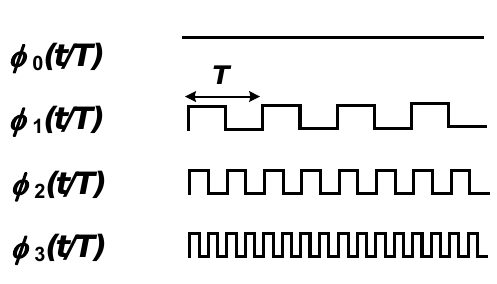
Figure 19. First four Rademacher functions.